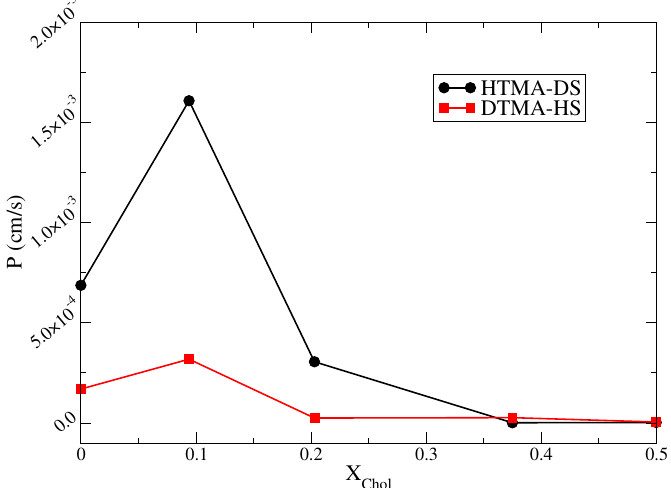
Figure 8. The water permittivity coefficients for HTMA-DS-Chol (black circle) and DTMA-HS-Chol (red square) bilayers as a function of cholesterol concentration X chol